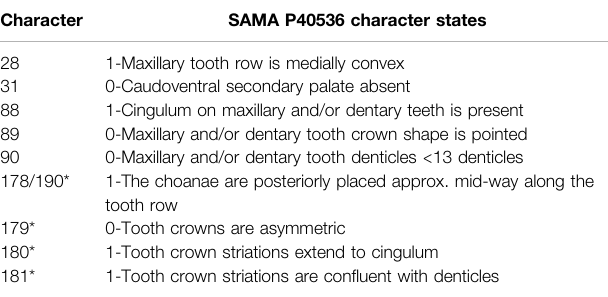
TABLE 2 | Characters coded for the phylogeny of SAMA